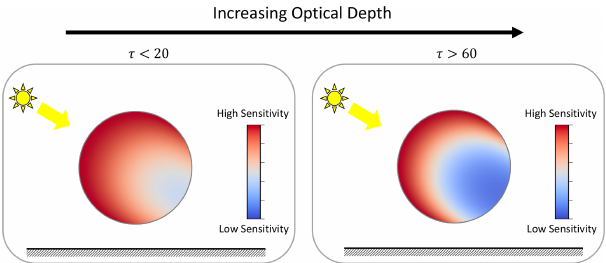
Figure 6. A conceptual diagram illustrating the decrease in magni- tude of the Jacobian elements in the solar direction through a cross section of a homogeneous spherical cloud. The mismatch in the magnitude of the Jacobian elements between the illuminated and shadowed sides increases as the optical depth